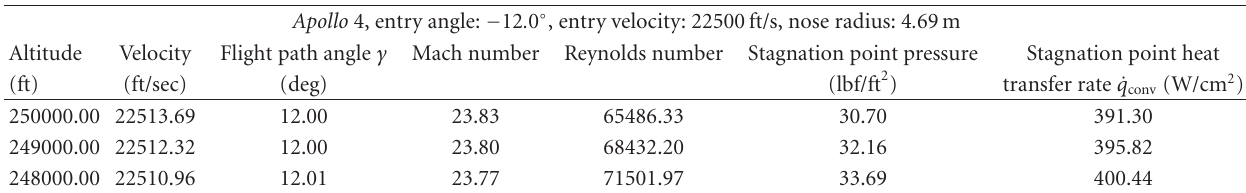
Table 1: OLAP driven trajectory analysis for Apollo 4 at an entry velocity of 22500 ft/s and R n = 4 . 69m.